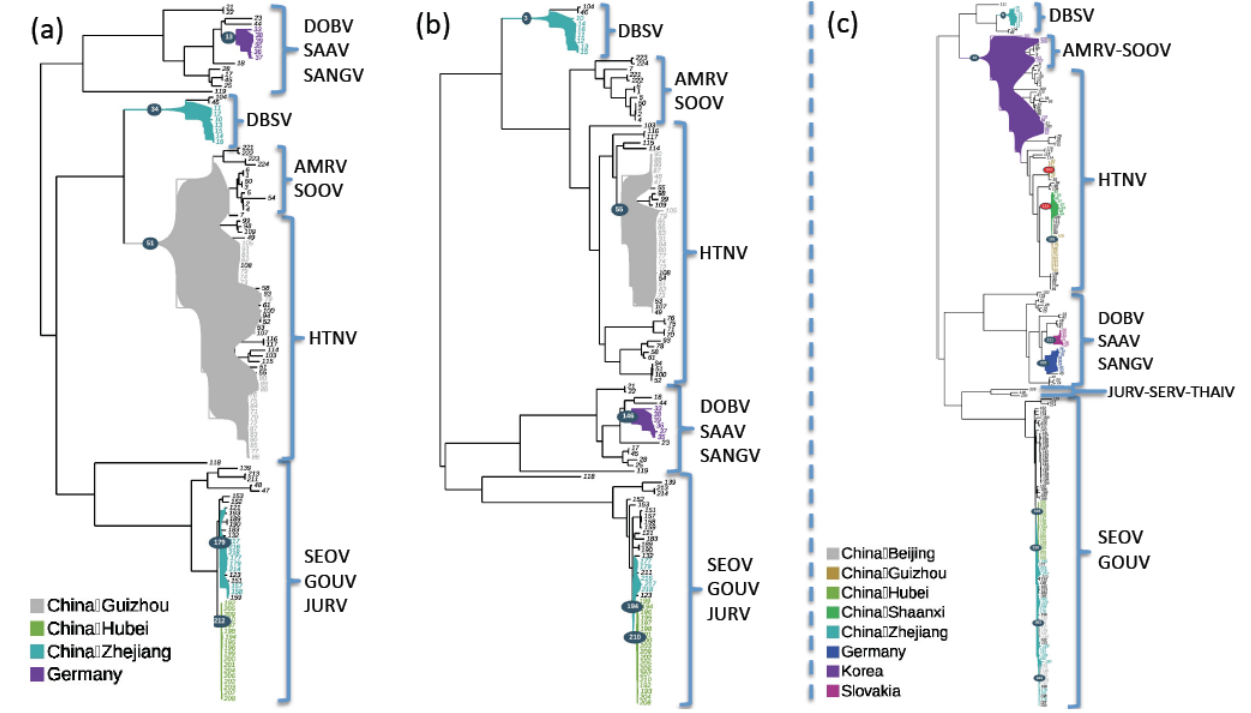
Figure 3. Detection of phylotypes (subsets of taxa with close phylogenetic relationships and common geographic trait values) among the phylogenies of M ( a ) and S, for the small dataset ( b ) and for the large dataset ( c ), segments of murine-associated hantaviruses by Phylotype [55]. Results are presented on the ML phylogenetic trees, in background and in which the selected phylotypes are represented by coloured regions. Phylotype identifiers are indicated in circles and refer to Pi in Table